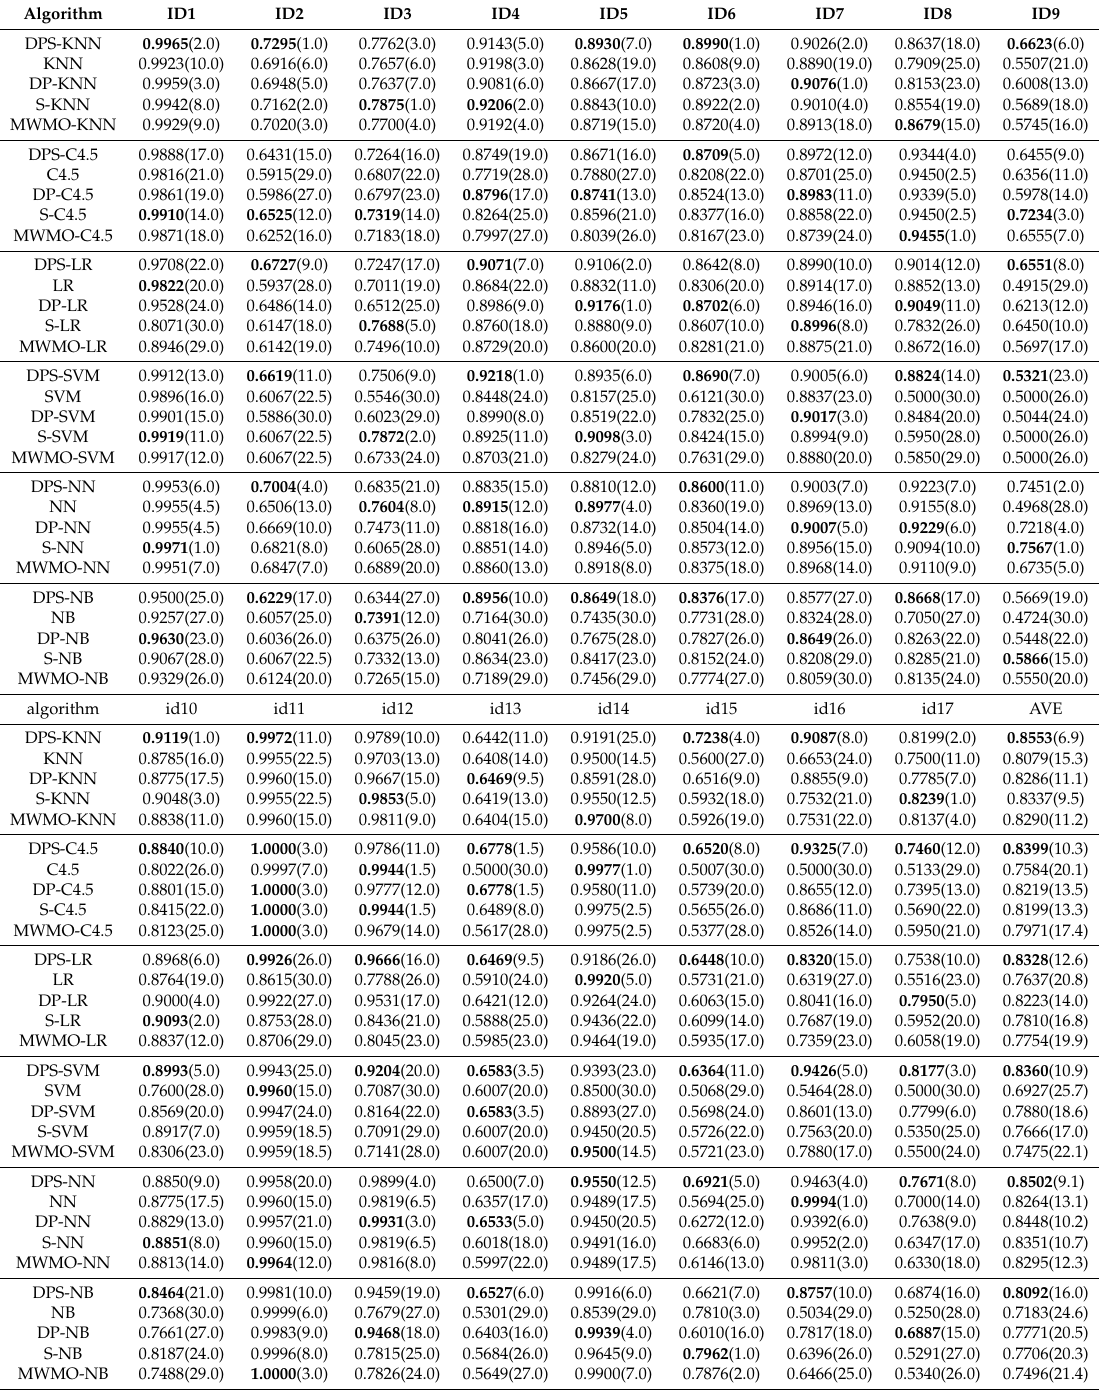
Table 6. Experimental results of models on AUC